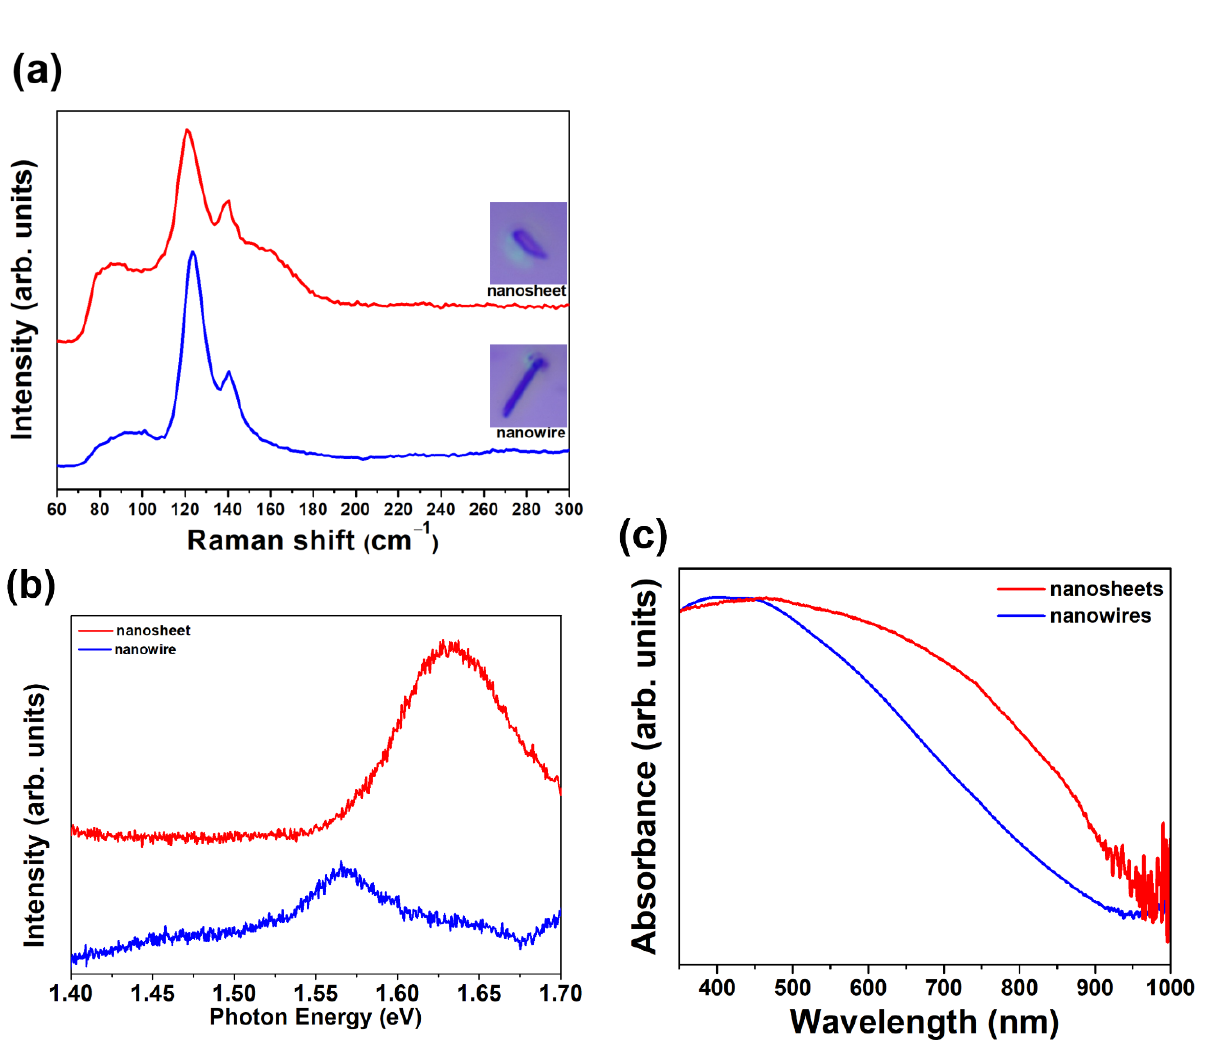
Figure 5. ( a ) Raman spectra of single GaTe nanowire and nanosheet. ( b ) PL spectra of single GaTe nanowire and nanosheet. ( c ) UV-visible absorption spectra of GaTe nanowires and